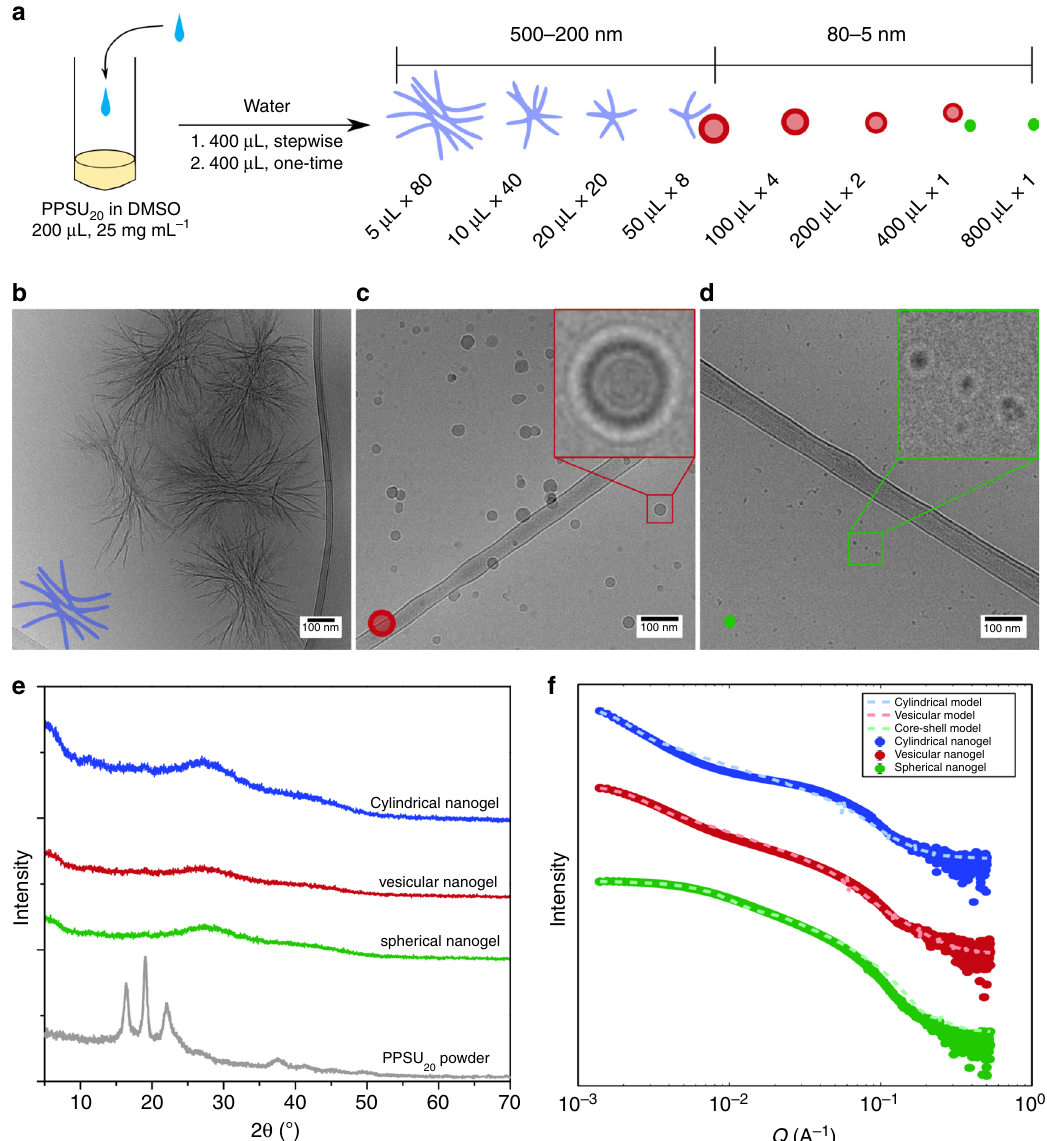
Fig. 2 Impact of hydration history on PPSU dynamic network self-assembly. a Fabrication of nanoscale hydrogels with distinct morphologies by homopolymer self-assembly. Externally controlling the self-assembly of PPSU 20 by stepwise addition of water to DMSO solutions of PPSU 20 . b – d Cryo- TEM images showing the typical cylindrical, vesicular, and spherical morphologies in water. Scale bar = 100 nm. Nanostructures were prepared by